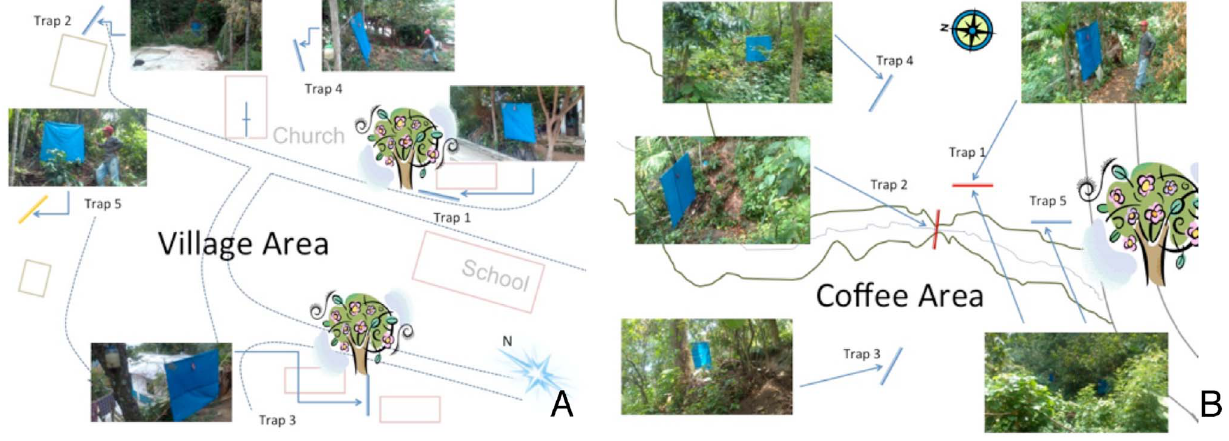
Figure 2. Position of traps at the two collection locations. Panel A: Trap positions in the village. Panel B: Trap positions in the coffee plantation. Arrows indicate the trap position relative to local landscape features and photos show the actual trap placement.